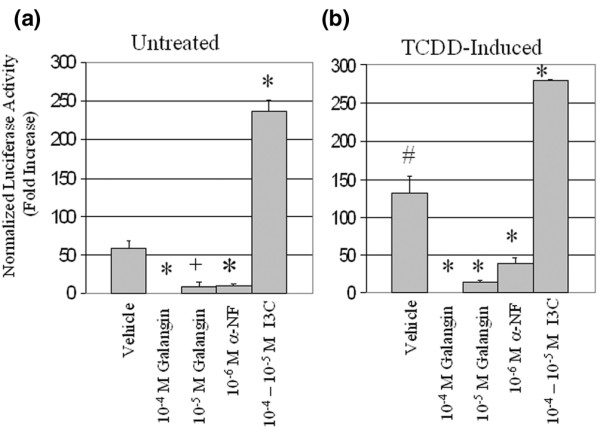
Galangin inhibits aryl hydrocarbon receptor-dependent pGudLuc reporter activity. Hs578T cells were left untransfected or were transfected with 0.5 μg/well renilla luciferase vector phRL-TK and 0.1 μg control pGL3 or pGudLuc vector per well and treated with 10-4 to 10-5 M galangin, 10-4 to 10-5 M indole 3-carbinol (I3C), or 10-6 M α-naphthoflavone (α-NF) in the (a) absence or (b) presence of 10-9 M 2,3,7,8-tetrachlorodibenzo-p-dioxin (TCDD). Cells were harvested 18 hours later and luciferase activity assayed. Firefly luciferase activity was normalized to renilla activity in each experiment. (a) Data pooled from 4 to 16 experiments are presented as the average fold increase relative to non-transfected cells + standard error. An asterisk (*) indicates a significant difference relative to vehicle-treated controls, p < 0.02. A cross (+) indicates p = 0.056. (b) Data pooled from 4 to 16 experiments are presented as the average fold increase relative to non-transfected cells + standard error. An asterisk (*) indicates a significant difference relative to vehicle-treated controls, p < 0.02. A hash sign (#) indicates a significant increase in activity relative to untreated, pGudLuc-transfected controls.